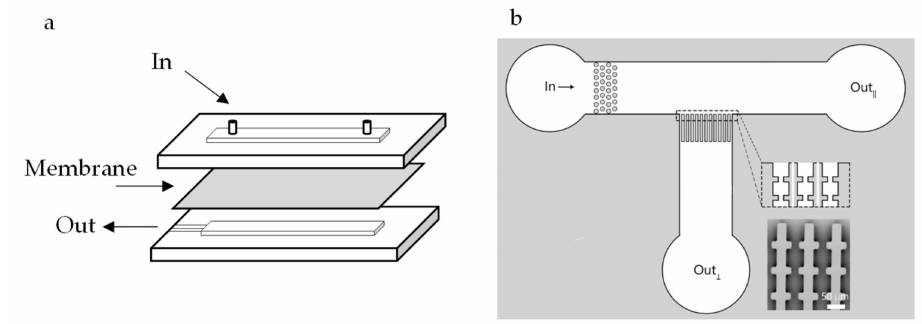
Figure 1. ( a ) Microfluidic configuration with an embedded membrane. ( b ) Microfluidic configuration with an array of parallel channels with the objective to mimic a membrane in an ideal